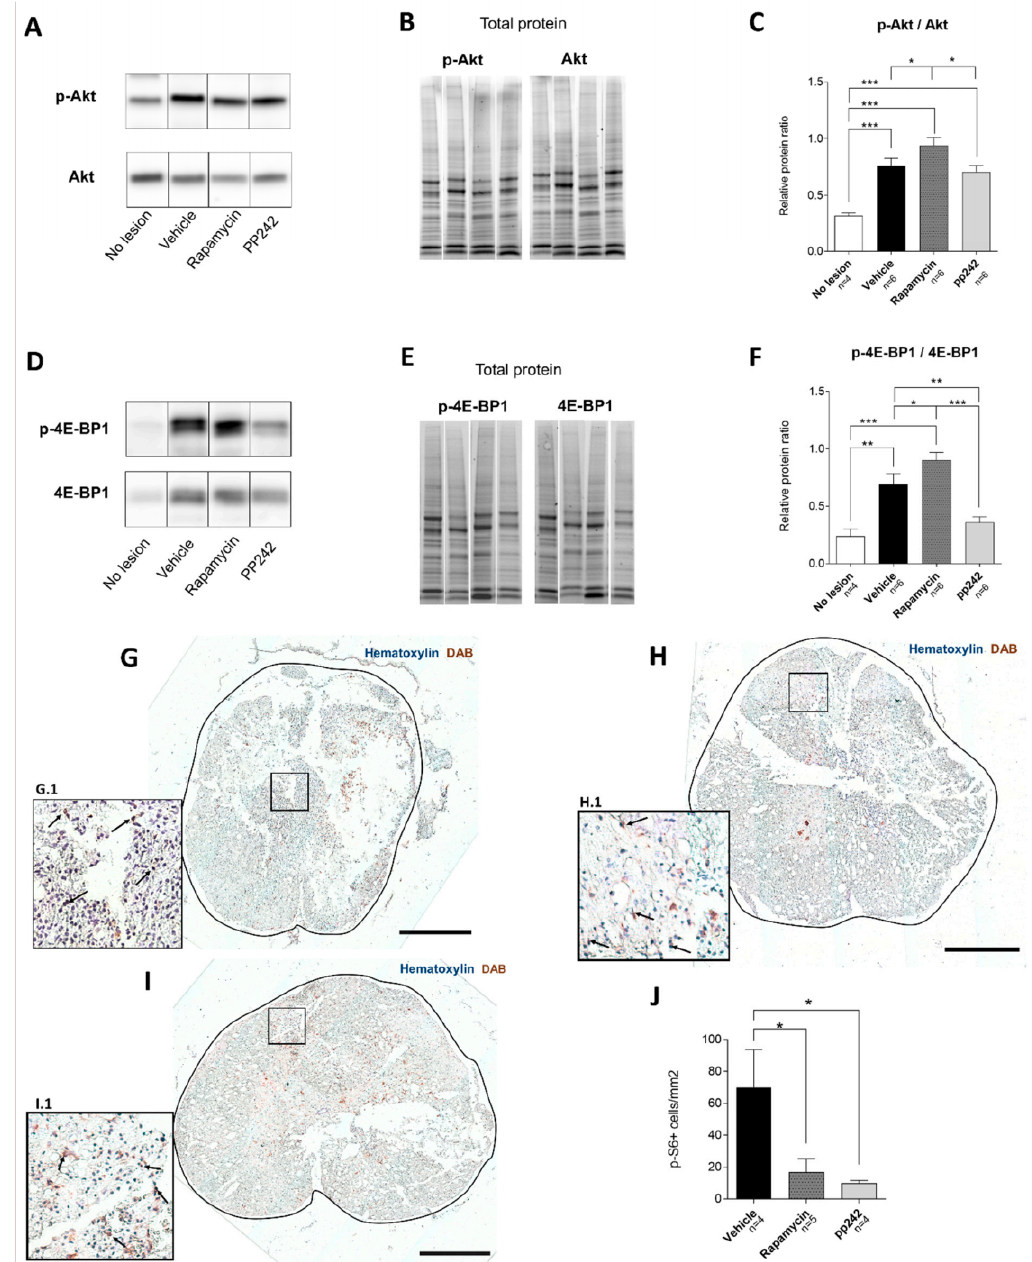
Figure 1. Suppression of mTOR pathway by RAPA or pp242 following SCI. Western blot analysis of proteins isolated proximal to the lesion site ( A – F ). Representative immunoblots of experimental and control groups are shown for each analyzed protein ( A , D ). Stain-free technology was used for visualization of total protein content ( B , E ) to ensure equal protein loading and normalization of relative band intensities of individual proteins. Representative total protein stains correspond to the sample lanes in representative blots of individual analyzed proteins. The phosphorylation level of proteins was assessed by calculating ratios of normalized phosphorylated and unphosphorylated protein band intensities. All rats after SCI had a higher p-Akt/Akt ratio compared to uninjured rats ( A – C ), and RAPA caused an increase in p-Akt/Akt ( C ). All rats after SCI had a higher p-4E-BP1/4E-BP1 ratio compared to uninjured rats ( D – F ), and RAPA caused an increase, while pp242 showed a comparable phosphorylation rate to that measured in healthy tissue ( F ). Immunohistochemical staining of spinal cord sections with phospho-S6 ribosomal protein (p-S6) and hematoxylin ( G – J ). Sections from rats treated with RAPA ( H ) and pp242 ( I ) had a significantly lower number of p-S6 positive cells per section area ( J ) compared to vehicle-treated controls ( G ). Scale bars: 500 µ m; G.1, H.1, and I.1 images are 1:4 magnifications of corresponding areas of the spinal cord. Arrows point to examples of DAB-stained cells. Data are shown as means ± SEM; * p < 0.05, ** p < 0.01, *** p <